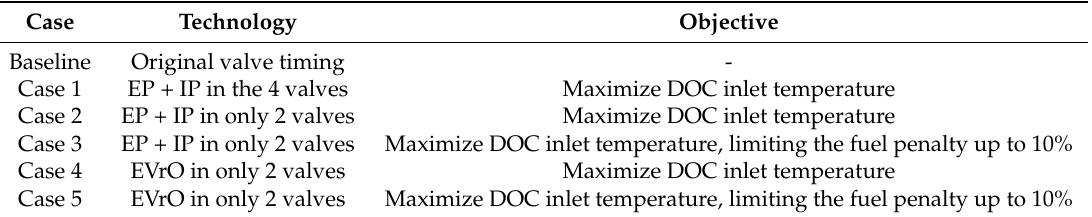
Table 3. Transient